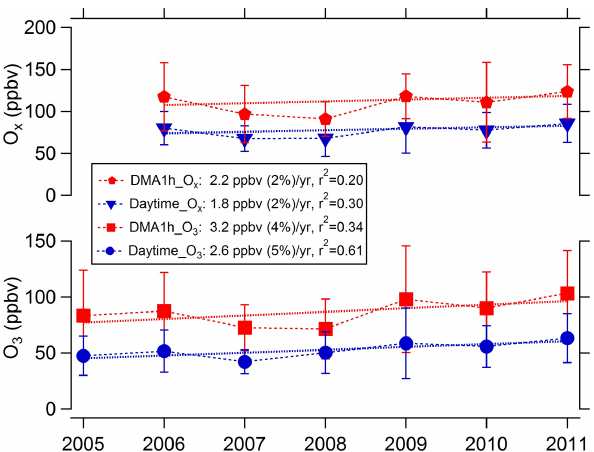
Figure 1. (Upper) variations in daytime averages (blue triangles) and daily maximum averages (red pentagons) of total oxidants (O x ) ; (lower) variations in daytime averages (blue dots) and daily maxi- mum averages (red squares) of ozone (O 3 ) in Beijing, August be- tween 2005 and 2011.